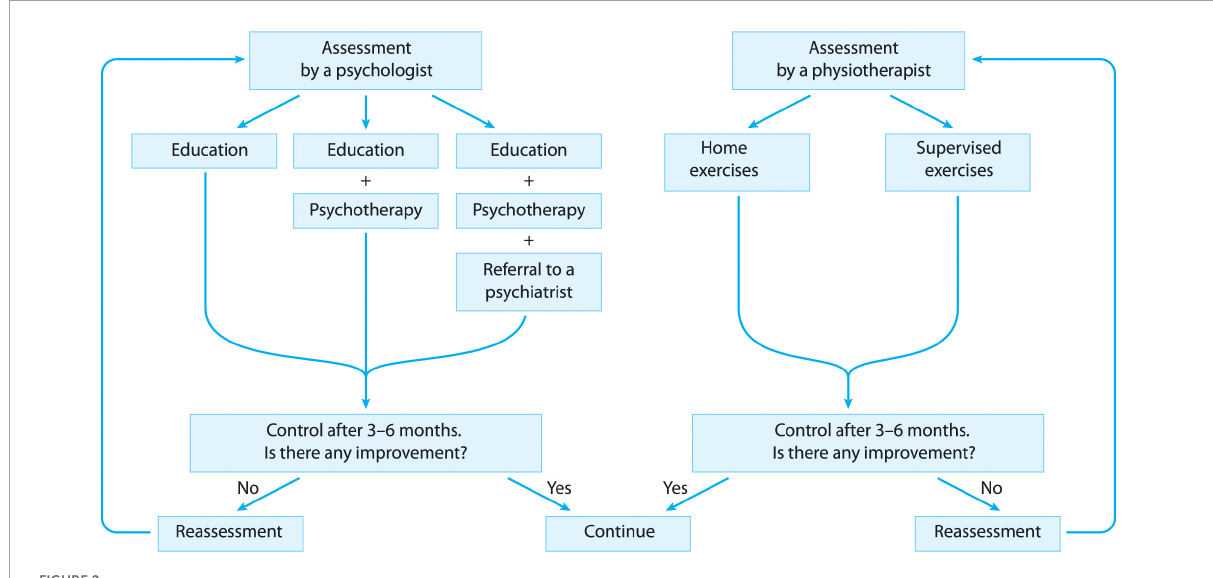
FIGURE2 Proposed structure of non-pharmacological treatment in